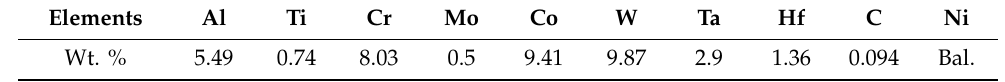
Table 1. The chemical composition of superalloy CM247LC (wt. %).